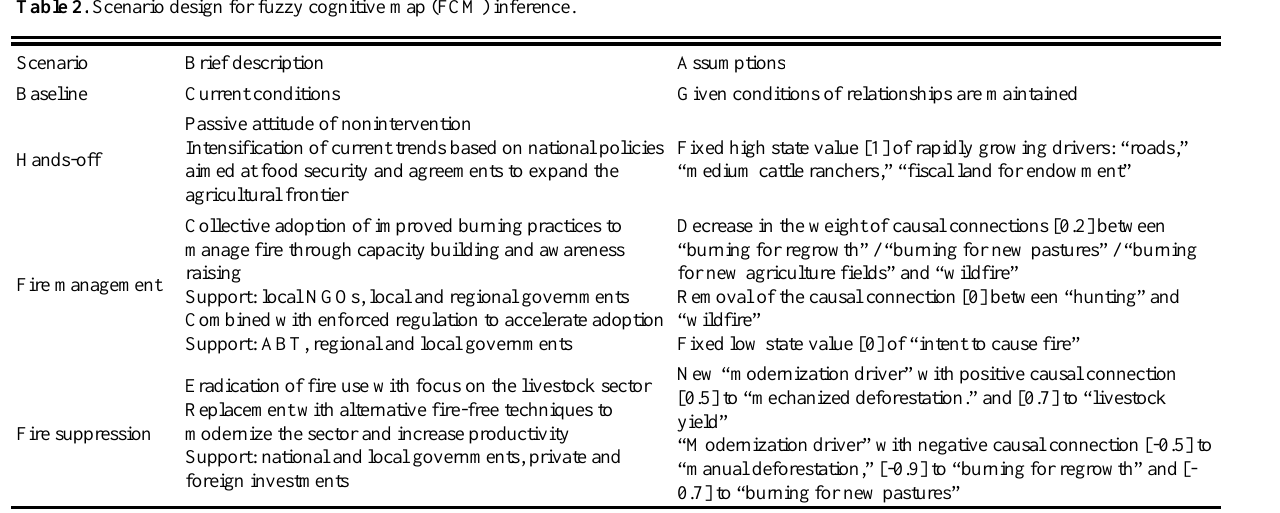
Table 2. Scenario design for fuzzy cognitive map (FCM)